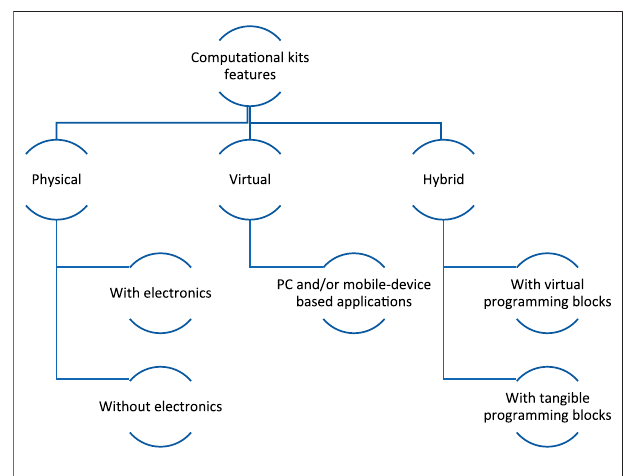
FIGURE 1 | A categorization of computational kits and toys appropriate for young age children based on their physical features (Adapted by Yu and Roque,